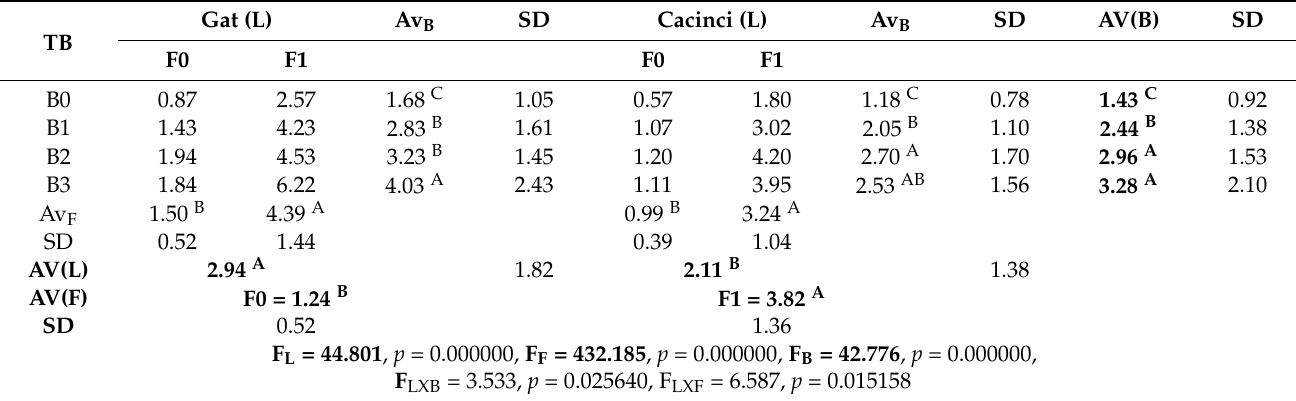
Table 8. Biochar and fertilization effects on winter wheat yield (t ha − 1 ) at the experimental sites Gat and Cacinci.